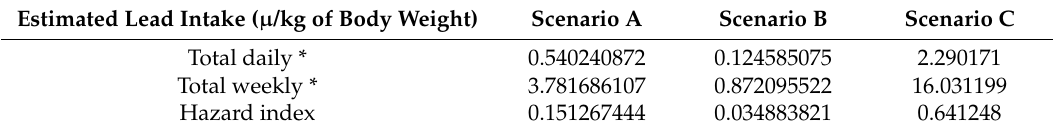
Table 6. Baroševac adult population’s weekly intake of lead and hazard index (deterministic